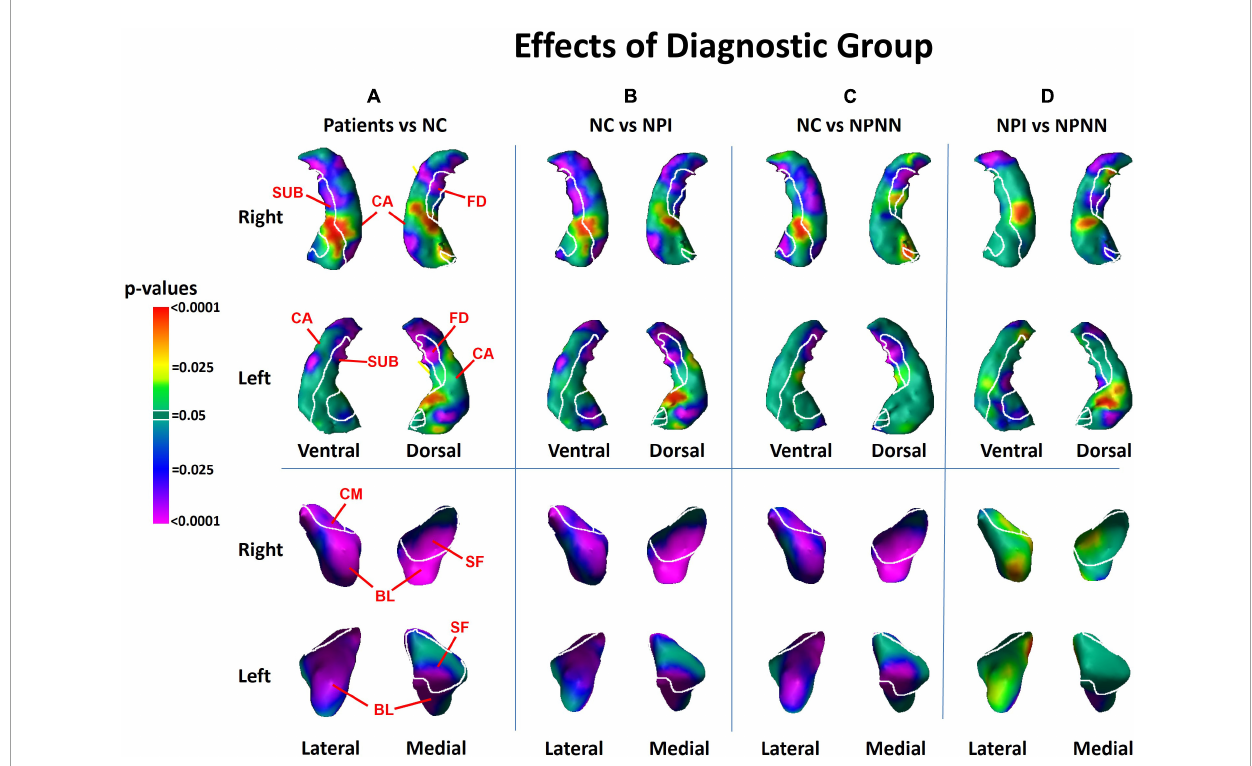
FIGURE1 Main effects of diagnostic group on surface morphologic features. The right and left hippocampus are shown in their dorsal and ventral perspectives. The right and left amygdala are shown in their lateral and medical perspectives. The cytoarchitectonic map overlies the structures. At each point on the hippocampal amygdala surface, the statistical significance (probability values) of differences in surface morphology across risk-groups are color coded. The color bar indicates the color coding for P -values associated with the main effect of diagnostic group, with warmer colors (yellow and red) indicating protruding surfaces, presumably from larger underlying volumes, and cooler colors (blue and purple) indicating indented surfaces and presumably smaller underlying volumes in those regions. P -values are thresholded at P < 0.05 after correction for multiple comparisons using false discovery rate (FDR). The statistical model included the main effect of diagnostic group, and the covariates of age, age 2 , sex, and minority status. Statistical maps for the differences in surface morphology of the hippocampus and amygdala are shown for (A) individuals with schizophrenia vs. healthy control (HC); (B) neuropsychologically impaired (NPI) vs. HC; (C) neuropsychologically near normal (NPNN) vs. HC; and (D) NPI vs. NPNN. CA, cornu ammonis; FD, fascia dentata; SUB, subiculum; SF, superficial nucleus; CM, centromedial nucleus; BL, basolateral